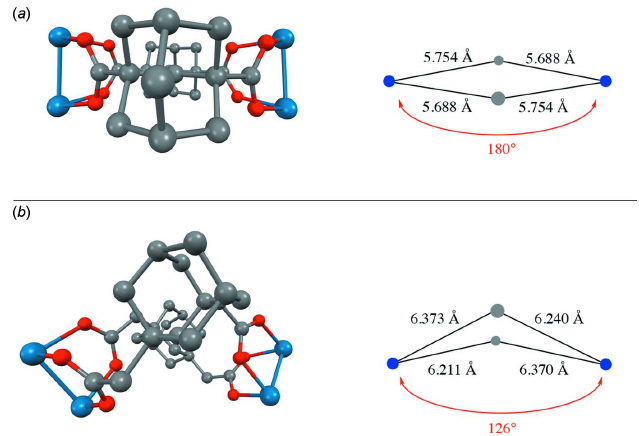
Figure 3 Views of the central shapes and core dimensions for ( a ) the title compound and ( b ) [Os 2 (CO) 6 ] 2 ( (cid:2) 4 -adamantane-1,3-diacetate) 2 . On the left are perspective views in which atoms toward the front appear larger and atoms toward the back appear smaller. On the right are illustrations of the underlying core shapes in which blue dots represent the centroids of the two Os—Os units and gray dots represent the centroids of the two adamantane moieties.